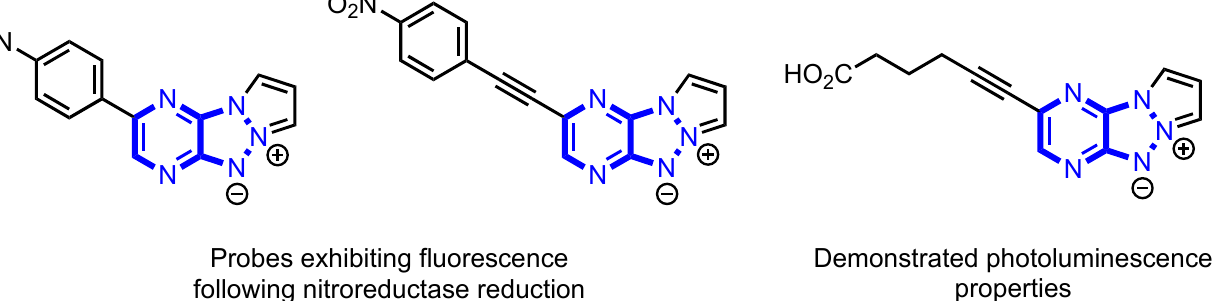
Figure 5. Compounds containing 1,2,3-triazolo[4,5- b ]pyrazines based on the nitro-pyrazinotriazapentalene scaffold [20].